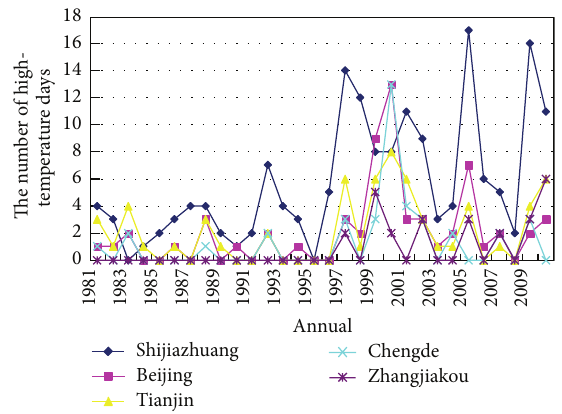
Figure2:Interannualvariationsofhigh-temperaturedaysinthefive representative cities.